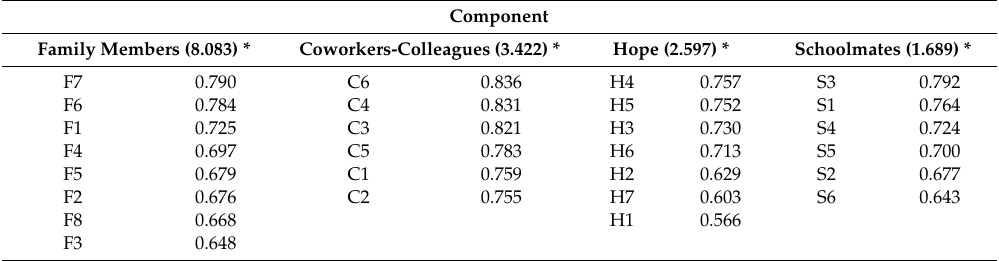
Table 3. The exploratory factor analysis.